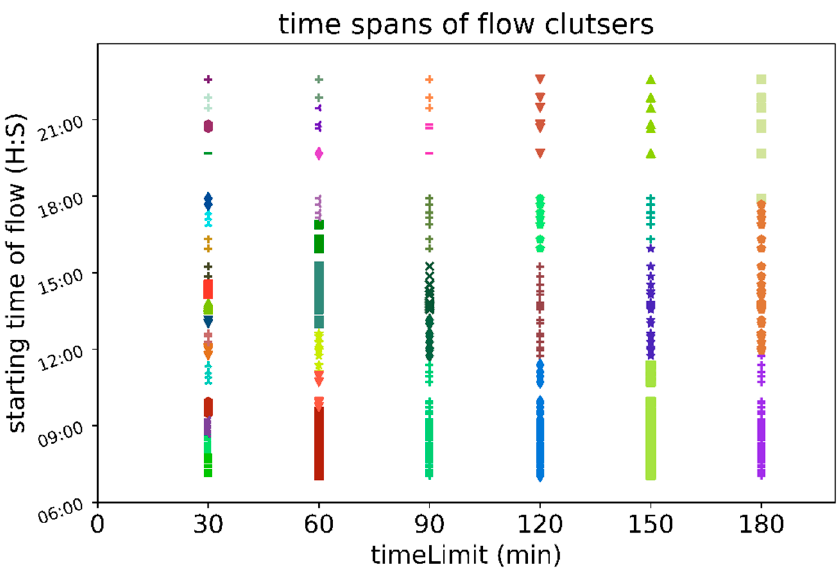
Figure 11. Time spans of the flow clusters under different values of timeLimit .